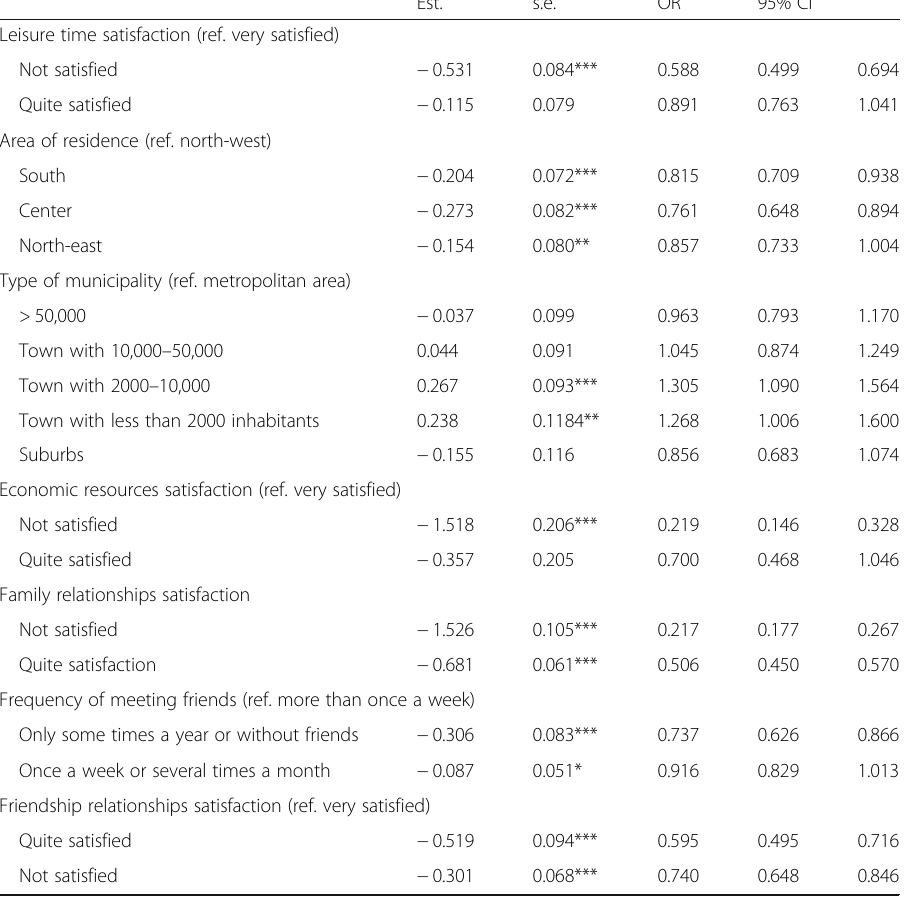
Table 3 Coefficient estimates ( β ) and their standard errors (s.e.), odds ratios (OR), and their 95% confidence interval of the binary logistic multilevel model for the life satisfaction (probability of being satisfied) (Continued)